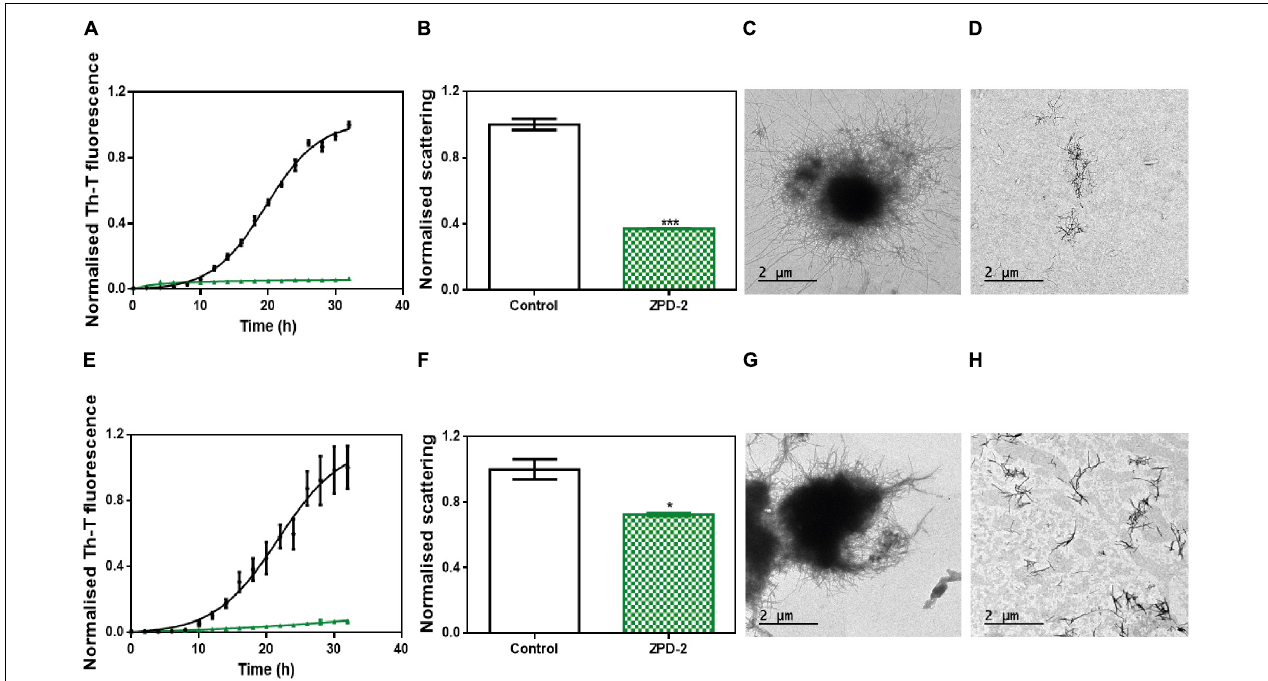
FIGURE 6 | ZPD-2 blocks the aggregation of two different α -synuclein strains. (A,E) Aggregation kinetics of α -Syn strains B (A) and C (E) in absence (black) and presence (green) of ZPD-2. (B,F) Light scattering final point measurements at 300 nm of untreated (white) and ZPD-2-treated samples (green) of strains B (B) and C (F) . (C,D,G,H) Representative TEM images of untreated α -Syn aggregates (C,G) and treated (D,H) samples for strains B and C, respectively. Th-T fluorescence is expressed as normalized means. Final points were obtained at 48 h after the aggregation reaction begins. Error bars are shown as standard errors of mean values, where p < 0.05 and p < 0.001 were indicated by ∗ and ∗∗∗ ,